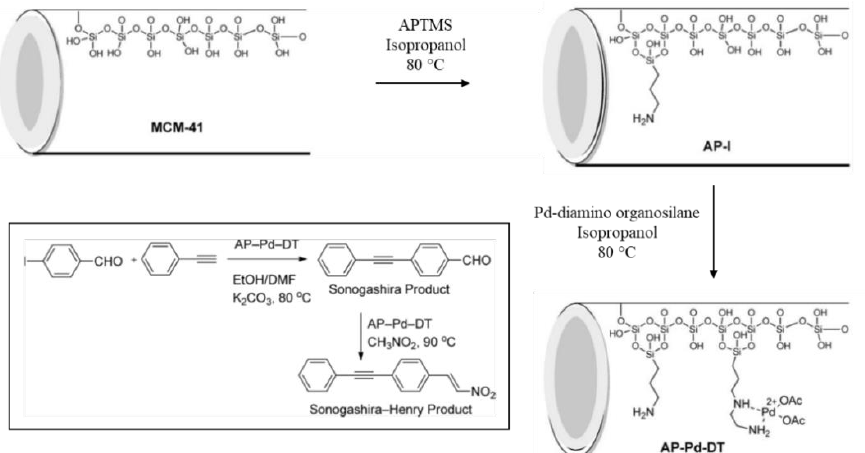
Figure 25. Schematic representation of the synthesis of bi-functional hybrid catalyst baring amino functionalities and Pd-diamino complexes. Inset: Sonogashira-Henry tandem reaction used for testing the activity of the hybrid catalyst. Reprinted with permission from [125]. Copyright 2011, John Wiley and Sons.